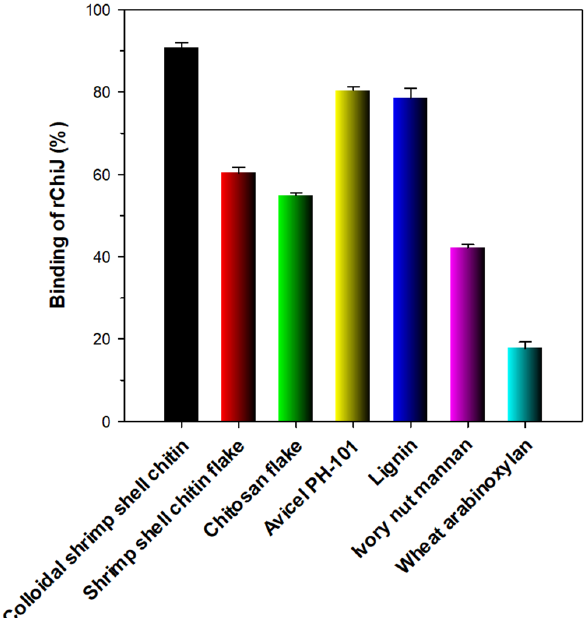
Figure 7. Binding of rChiJ to insoluble polymers. The values are mean ± SD of triplicate tests.